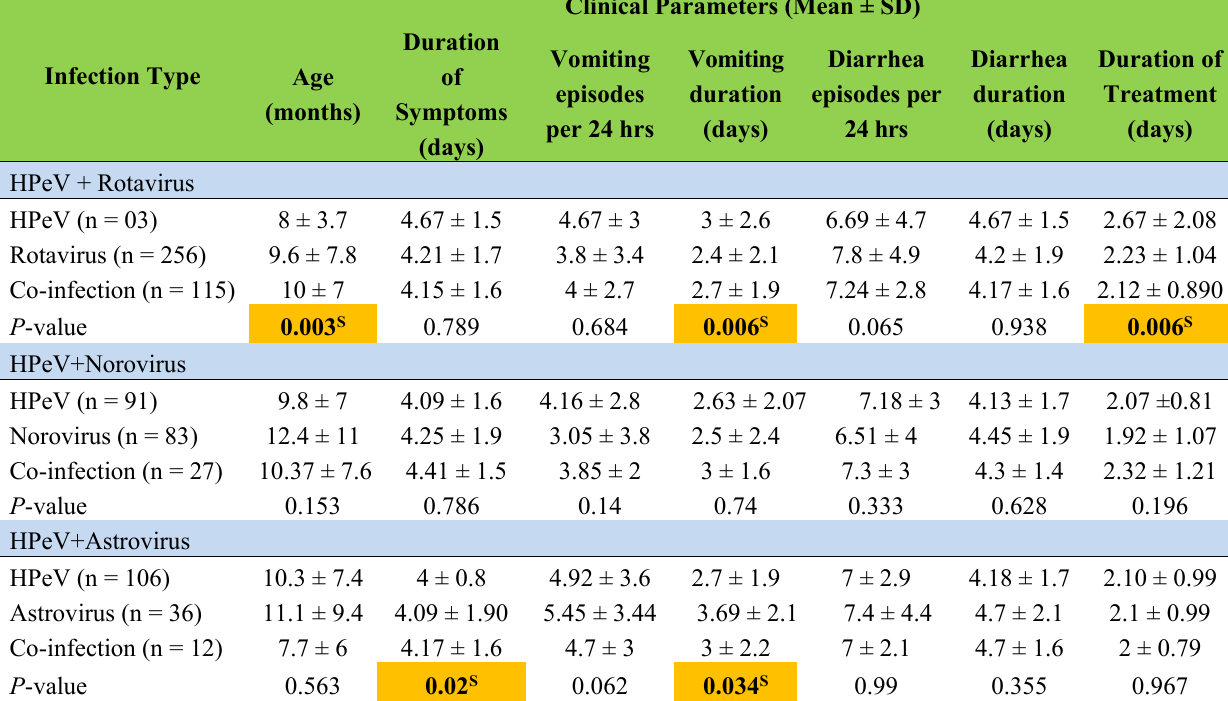
Figure 1. Age-wise distribution of cases that tested positive for rotavirus, parechovirus, norovirus, and astrovirus, during 2009–2010. Table 1. Comparison of quantitative clinical parameters between subjects infected with the four different viruses, i.e. , rotavirus, parechovirus, norovirus, and astrovirus. Infections were categorized into single and co-infection with dual viruses. P -value ≤0.05 was considered significant and are highlighted in yellow. Mean ± SD values are given for each clinical parameter. “S” in superscript indicates significant p-